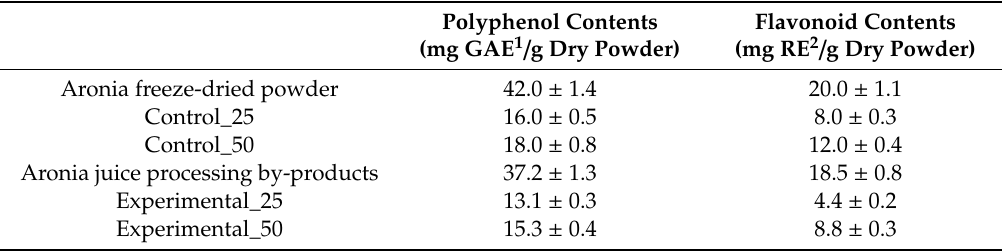
Table 3. Total polyphenol and flavonoid contents of aronia powder and